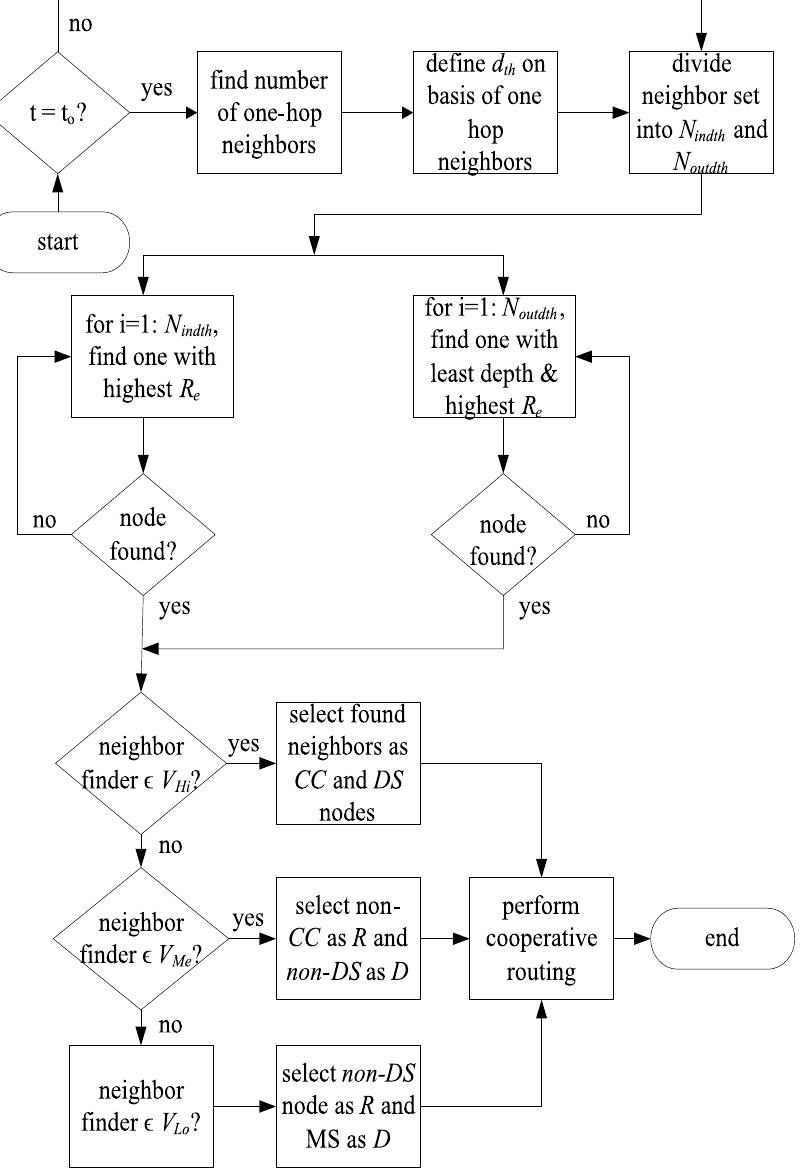
Figure 4. Selection of relay and destination